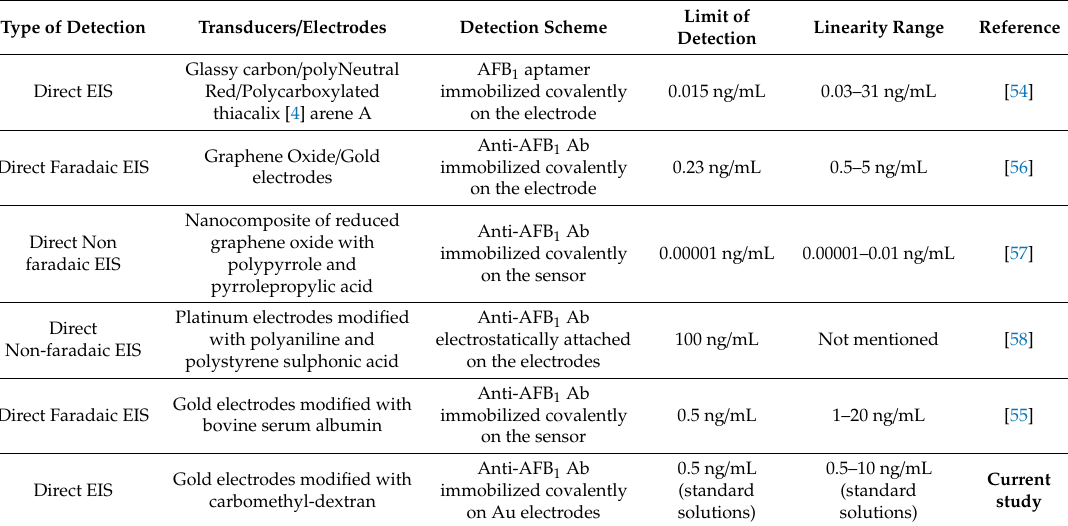
Table 4. Comparison of the analytical characteristics of the proposed impedance-based immunosensor with other electrochemical impedance immunosensors for